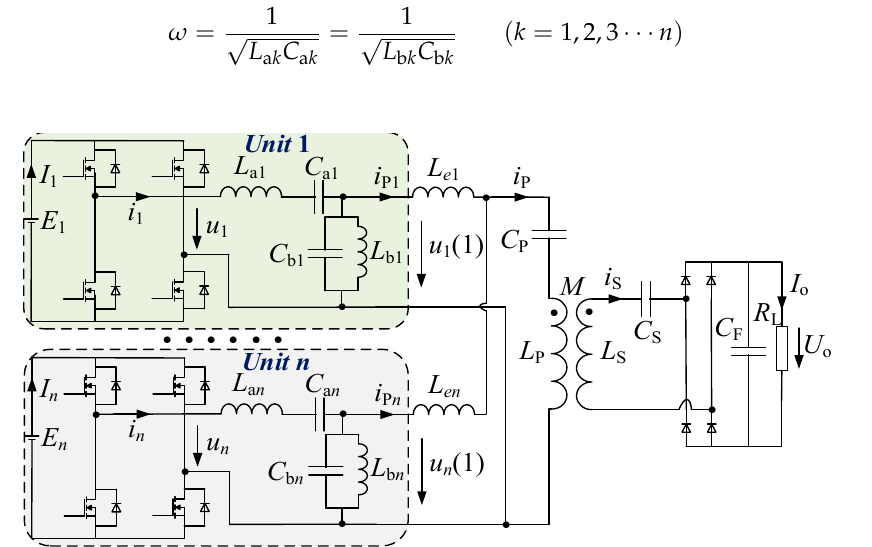
Figure 1 . The inductive power transfer (IPT) system based on parallel-connected inverter with the series-parallel resonant tank.